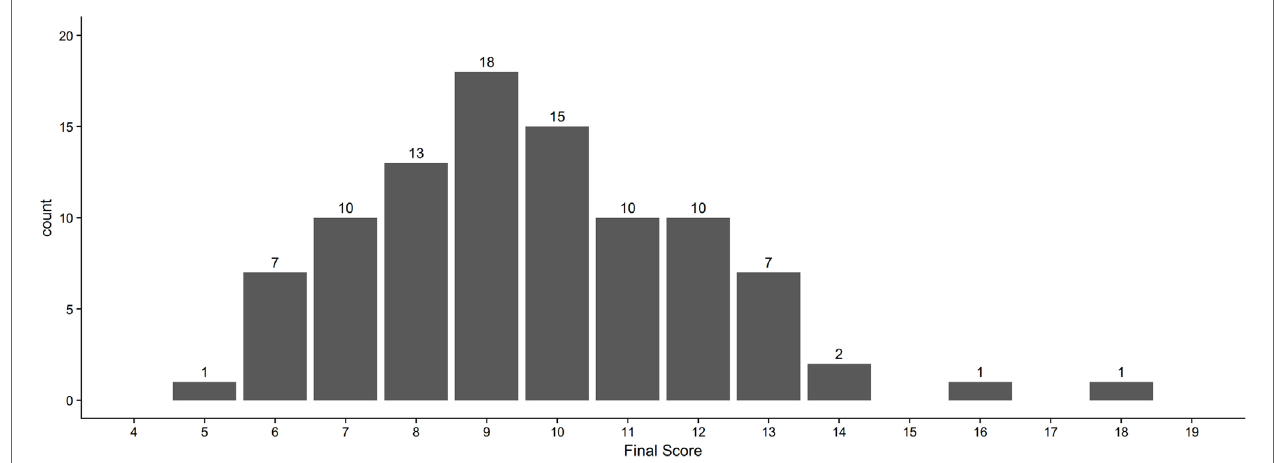
FigUre 1 | Count distribution of individual question responses for questions 1–9 (a–i) and total score on prostate cancer screening conversation